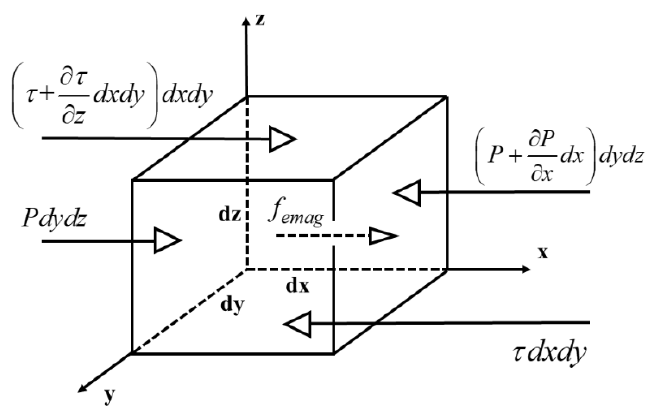
Figure 2. The force analysis of the liquid film infinitesimal element.